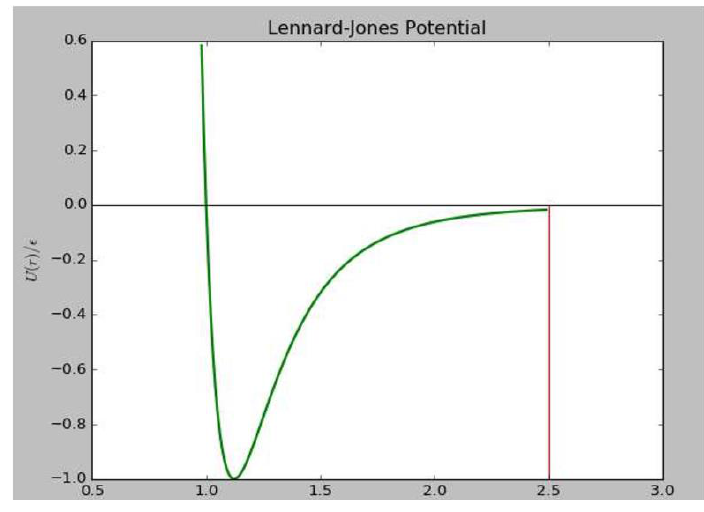
Figure 5. Leonard-Jones 12-6 potential.